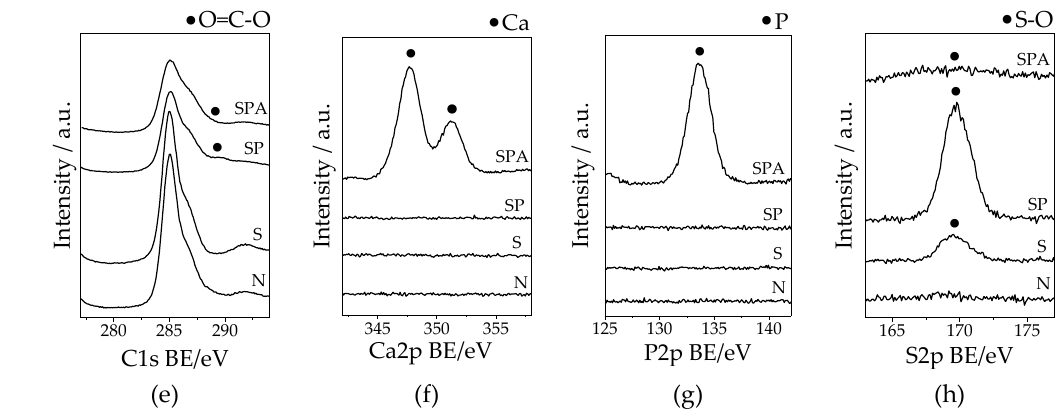
Figure 2. XPS narrow spectra around binding energy of C1s, Ca2p, P2p, and S2p on the surfaces of ( a – d ) pure PEEK and ( e – h ) 50C-PEEK.